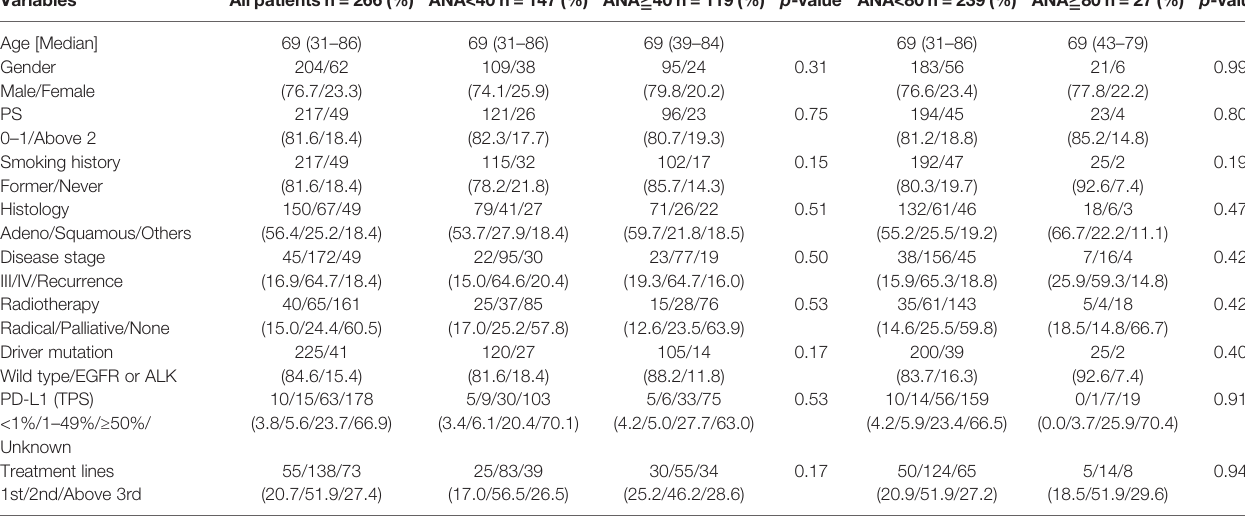
TABLE 1 | Patient characteristics according to ANA titer. Variables